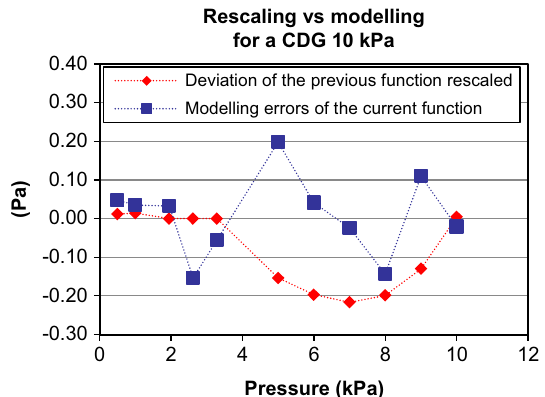
Fig. 6. Difference between the calibration function of a 10kPa full scale CDG obtained in one case by modelling the calibration data ( f t ), and in the other case by applying a correction factor k CDG to the previous calibration function ( k CDG (cid:3) f t (cid:1) 1 ). Here k CDG is the slope coef fi cient of the least squares fi t to a straight line that is used to estimate the reference pressure p FPG as a function of the CDG pressure modelled with the function ( f t (cid:1) 1 ), in the range between 40% and 80% of the full scale of the CDG. This difference is plotted together with the residuals of the model: ( f t (cid:1) p FPG ).